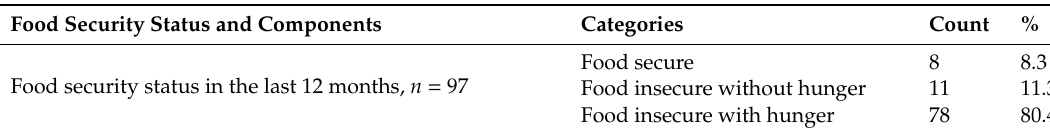
Table 2. Factors related to food insecurity among recipients of Charitable Food Services in Inner City Perth Western Australia (WA), January 2016 ( n =